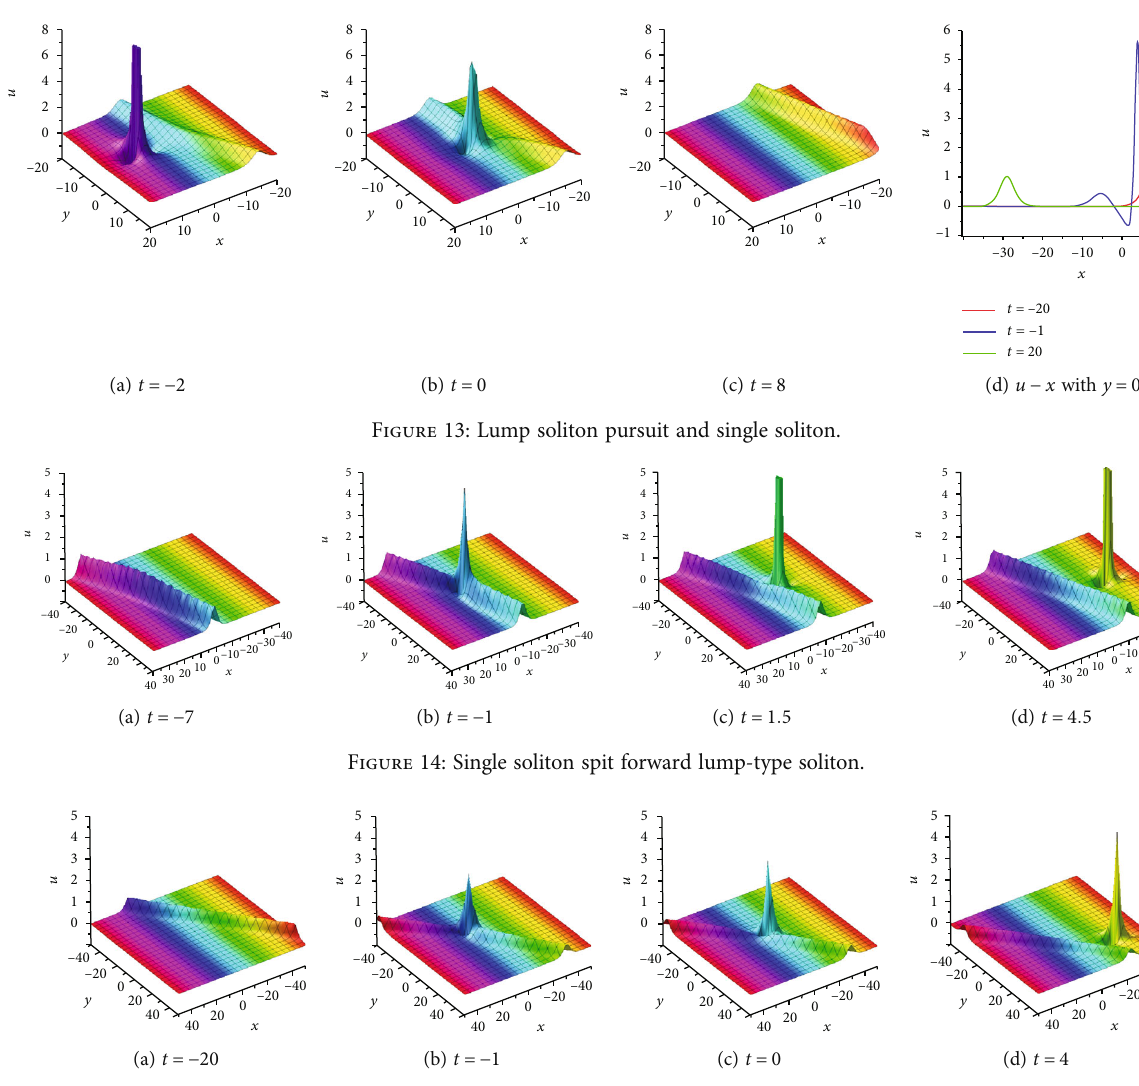
Figure 15: Single soliton spit backward lump-type